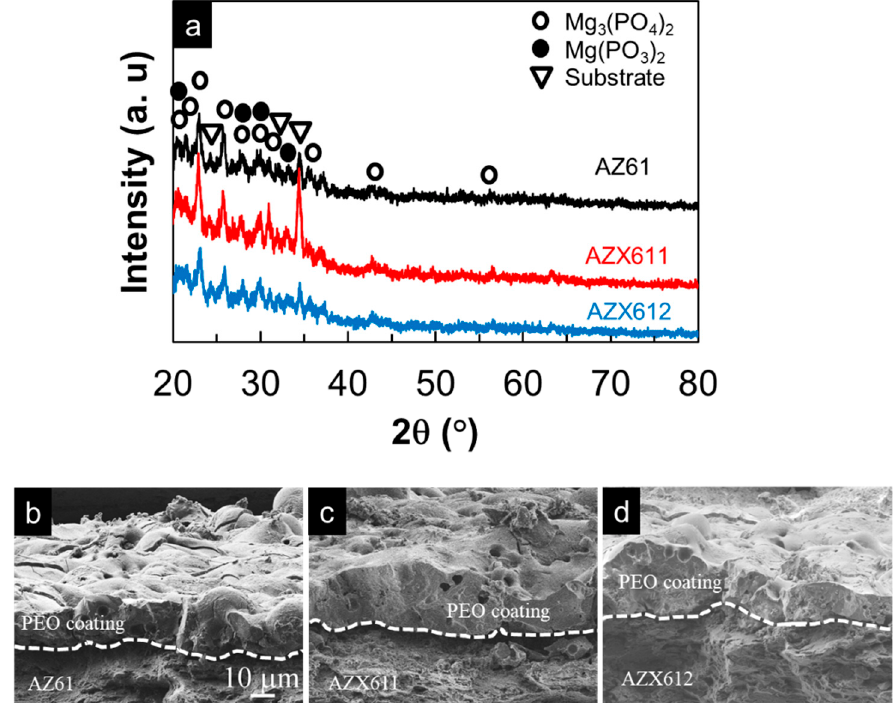
Figure 4. ( a ) X-ray di ff raction pattern of plasma electrolytic oxidation (PEO) coatings and the corresponding cross-section FE-SEM images of the coating on ( b ) AZ61, ( c ) AZX611, and ( d ) AZX612 resulting from 20 min anodization in 0.5 M Na 3 PO 4 solution at 25 ◦ C. The scale bar applied to all images.